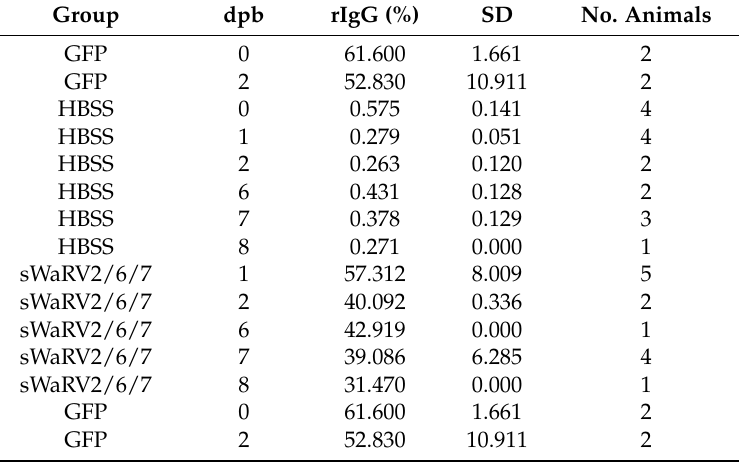
Table A7. This table shows the relative IgG values of milk samples of the dams from experiment 2. These dams raised the pups further analyzed in Figure